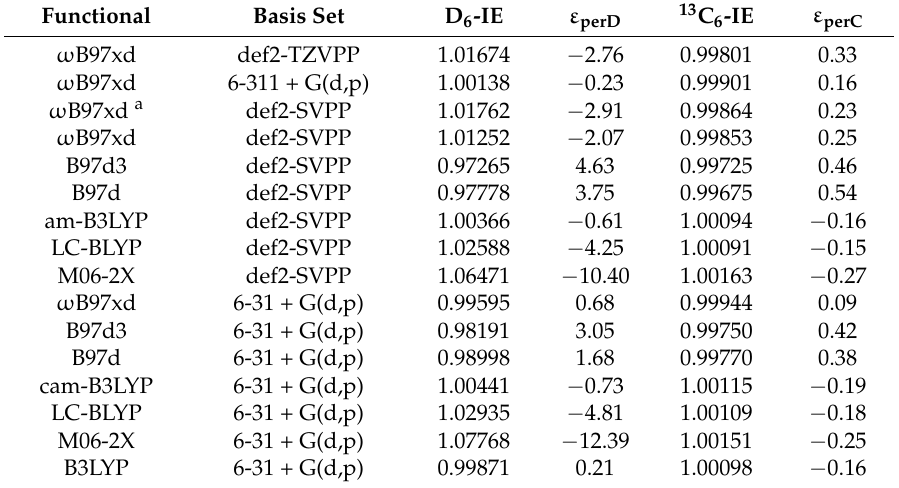
a results obtained for the C